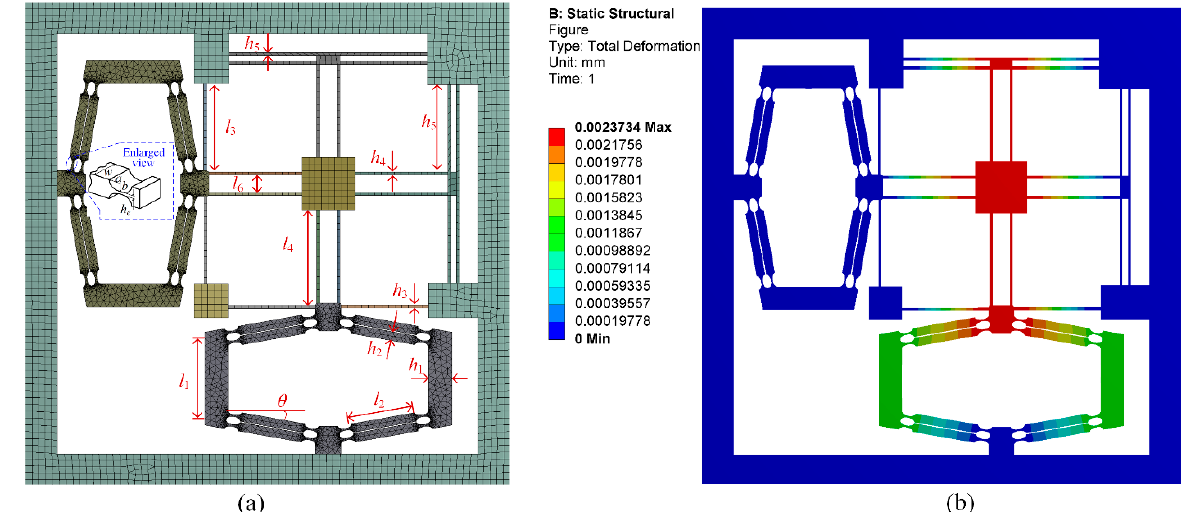
Figure 11. Finite element analysis. ( a ) geometric parameters; ( b ) result of one simulation set.